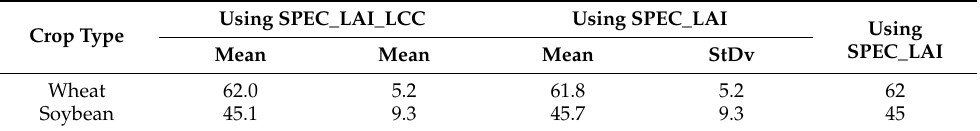
Table 4. ALA adj (degrees) obtained through PROSAIL parameterization, based on the measured data of wheat and soybean.